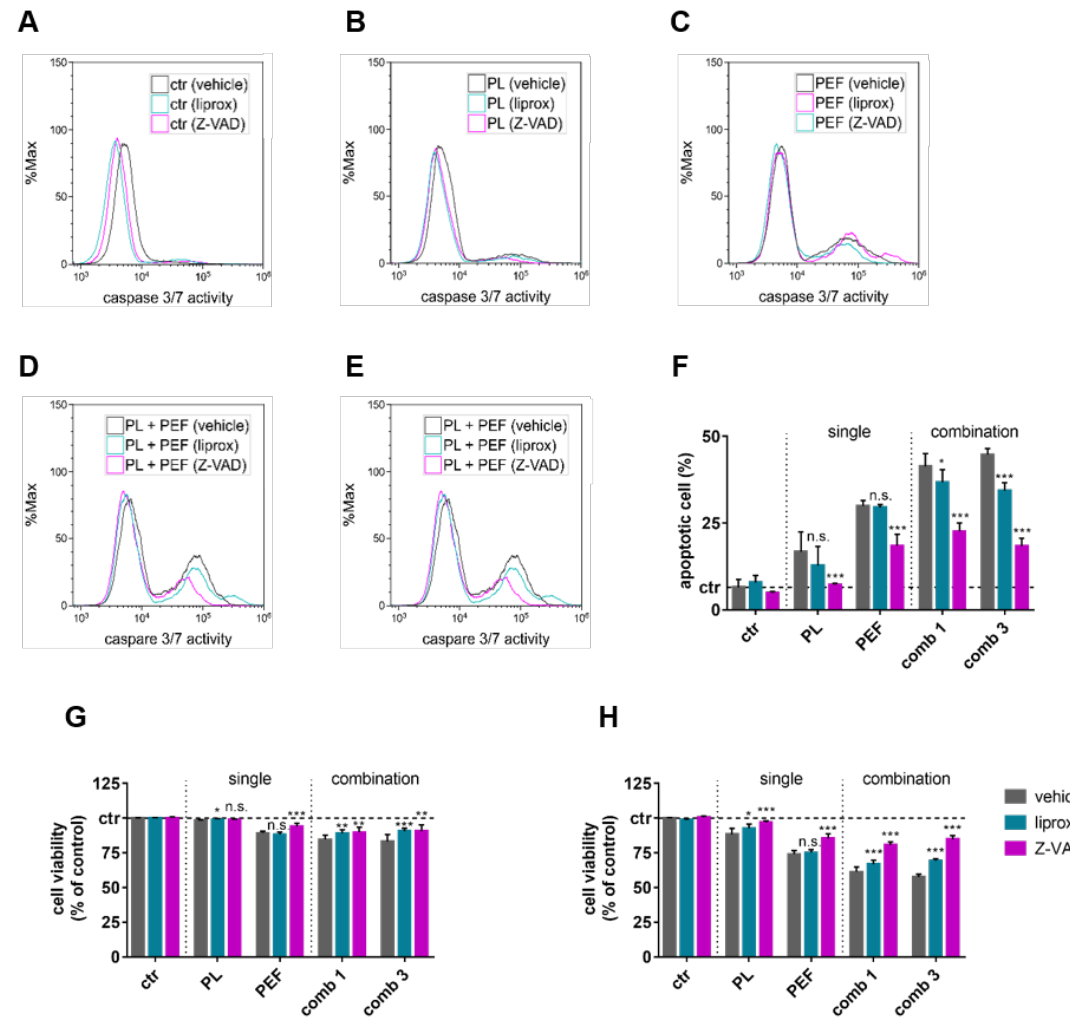
Figure 7. Influence of cell death inhibitors on cell viability after mono and combination treatments. The plasma exposure time was 40 s, and the electric field strength was 0.9 kV / cm. The cells were pretreated with liproxstatin-1 (liprox-1) or Z-VAD-FMK (Z-VAD) and stained with CellEvent Caspase-3 / 7 Green Detection Reagent 24 h after control conditions ( A ), plasma treatment ( B ), PEF treatment ( C ), plasma plus PEF treatment ( D ), or PEF plus plasma treatment ( E ). Apoptotic cells (caspase 3 / 7 active cells) were quantified 24 h after the treatments ( F ), as well as the cell viability after 4 ( G ) and 24 h ( H ). The significant di ff erences of cells without any antioxidants compared to the liprox-1 and Z-VAD pretreated cells were determined by t-test. Data are shown as one representative ( A – E ) or mean + S.E. ( F – H ) of three independent experiments. ctr = control; PL = plasma; PEF = pulsed electric fields; comb = combination; n.s. = not